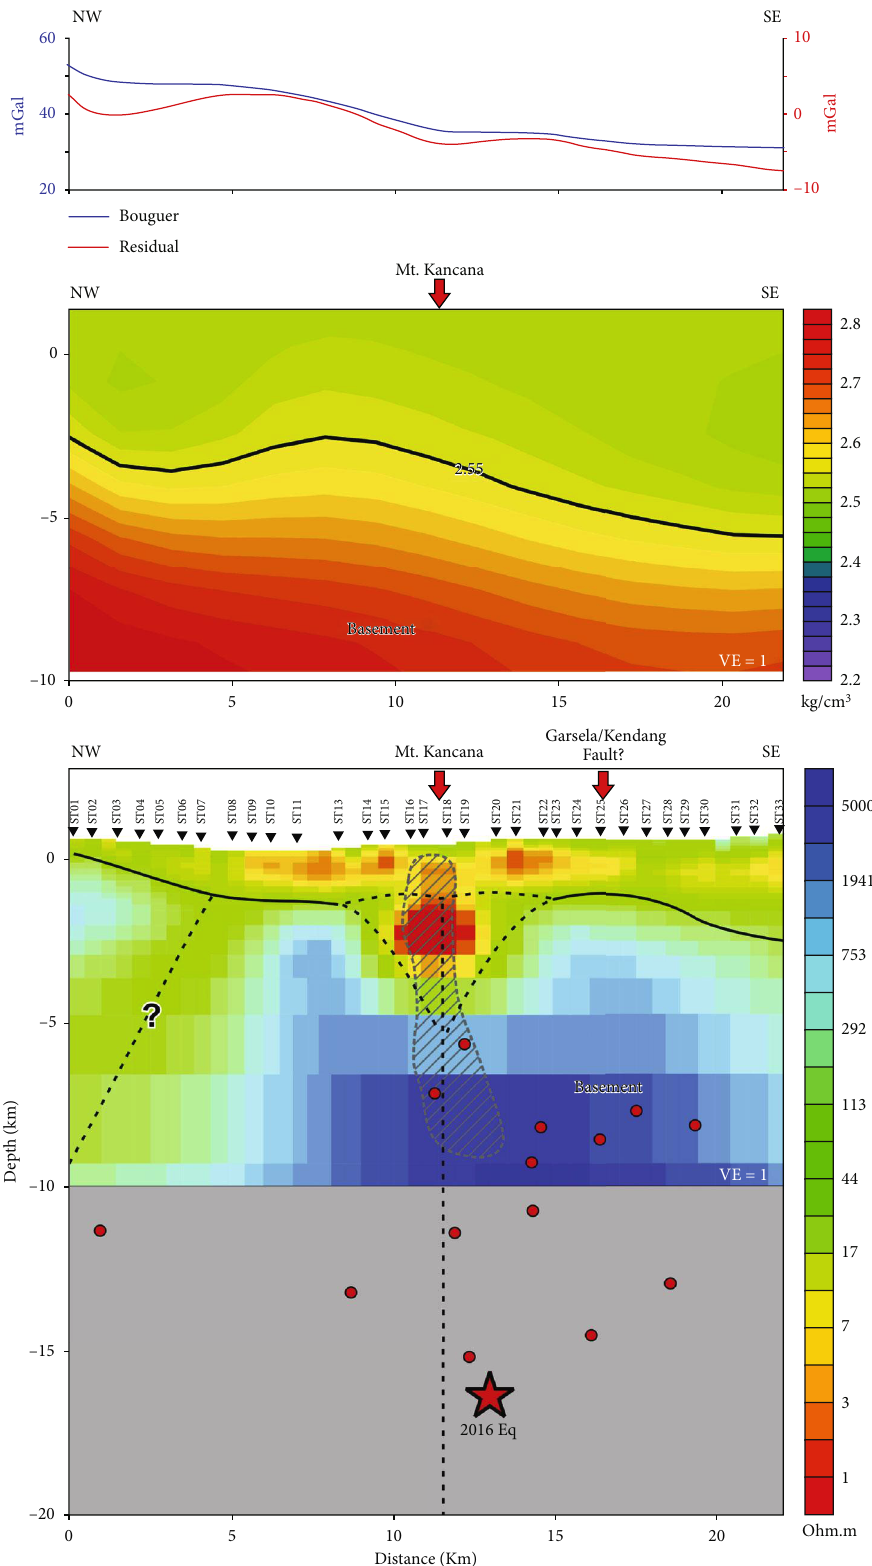
Figure 16: Interpretation of the density (top) and resistivity (bottom) models of line E-E ′ . The resistivity model shows a basement discontinuity in the western part of the cross-section and a conductive body beneath Mt. Kencana. MEQ (grey shaded area) cluster observed 4 km south Mt. Kencana